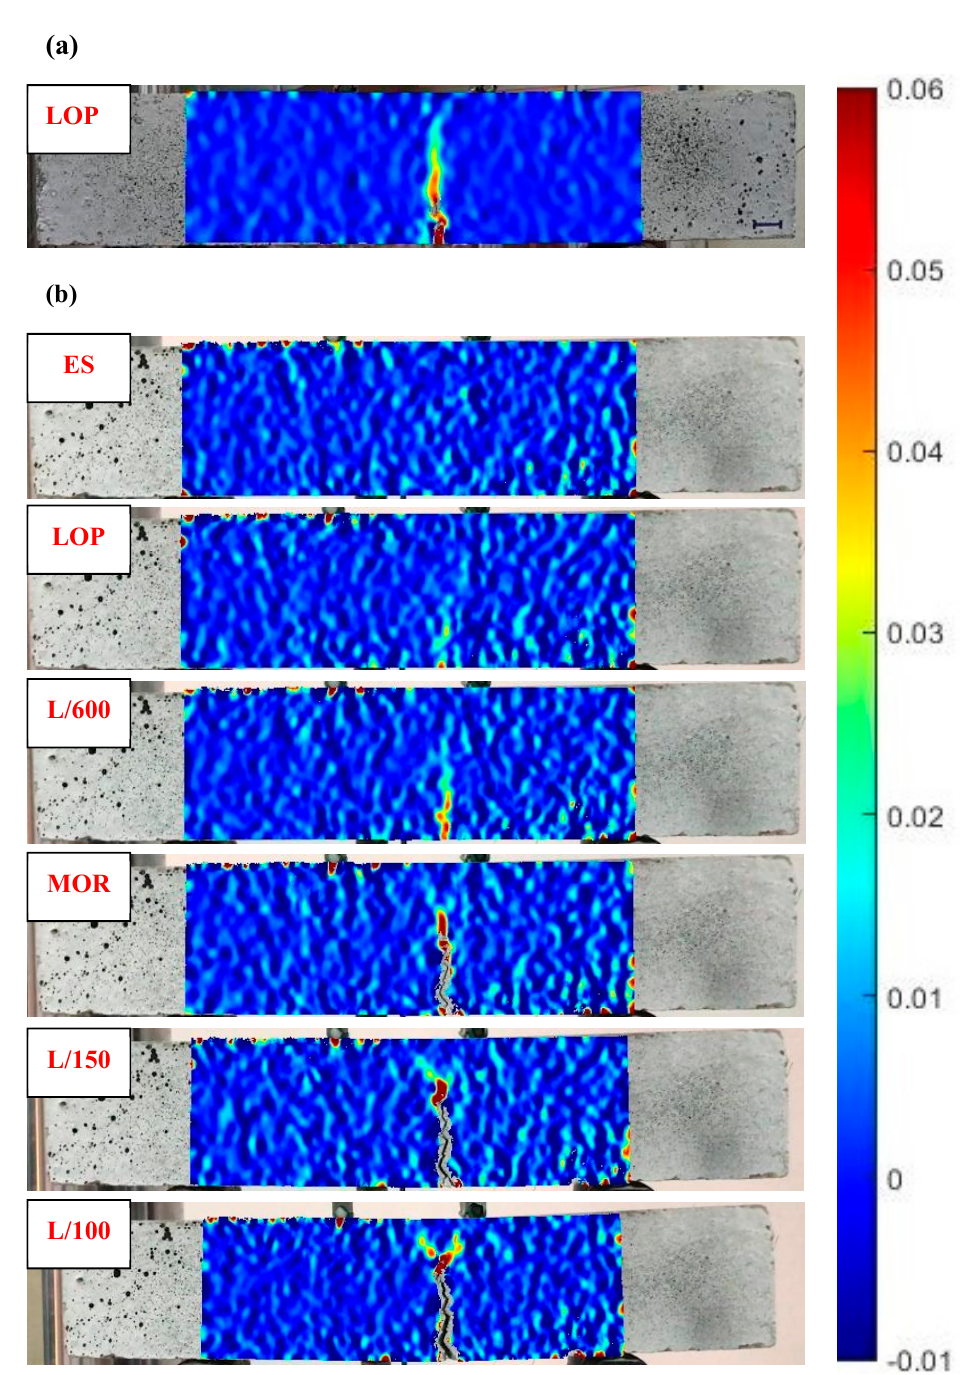
Figure 12. DIC images indicating crack propagation in bending specimens at key points shown in Figure 3. ( a ) S0 specimen. ( b ) S0.6 specimen. The DIC images corresponding to the L/100 (3 mm) deflection level of all FR-AASC mixtures are demonstrated in Figure 13. The formation of a twisty main crack in fibrous mixtures revealed that the failure mode underwent a transformation from the brittle mode